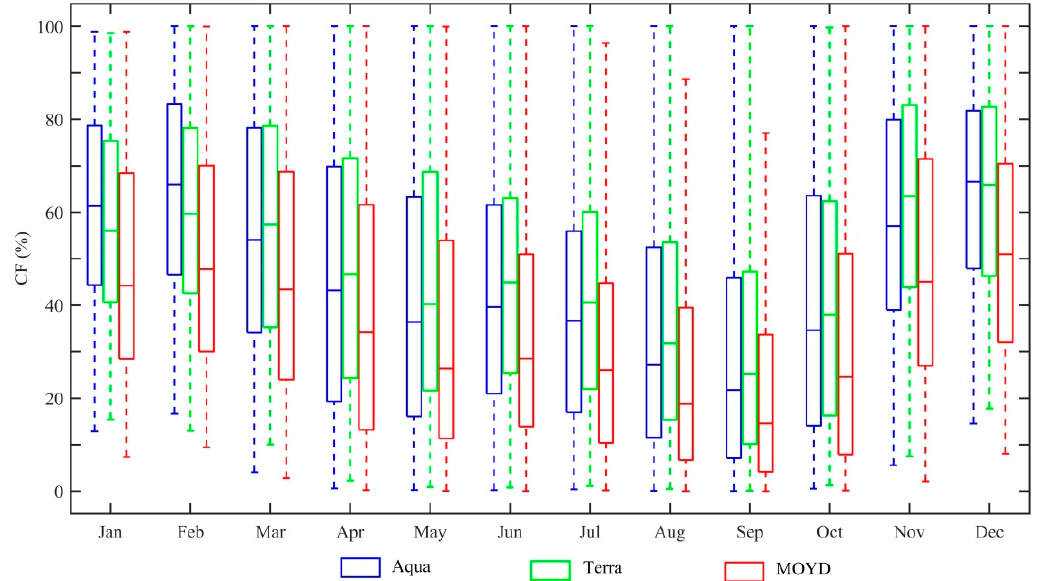
Figure 4. Monthly medians and interquartile ranges of cloud fraction (CF) in the original MODIS Aqua, Terra, and MOYD images. The remaining clouds were completely removed by conditional probability interpolation method based on a space-time cube (STCPI).